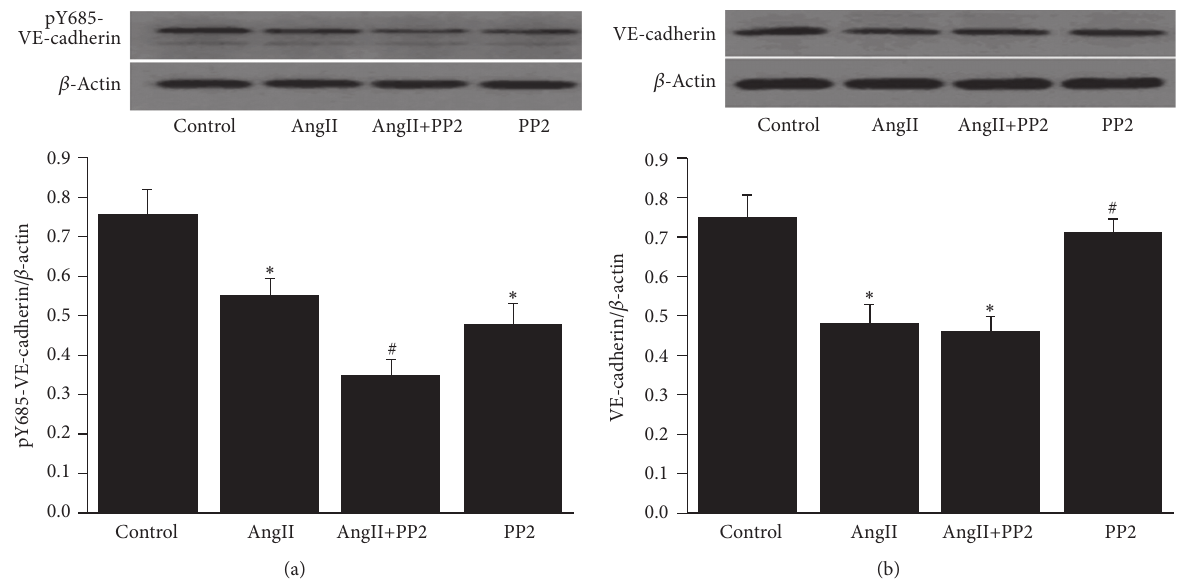
Figure5:DownregulationoftotalpY685-VE-cadherinproteininlunginducedbyAngII.(a)ThelevelofpY685-VE-cadherinwasremarkably decreased in the AngII group compared with the control group. AngII+PP2 induced further downregulation of pY685-VE-cadherin, while the pY685-VE-cadherin was obviously reduced in the control group after PP2 interference. (b) The VE-cadherin was remarkably reduced in the AngII group compared with the control group, but the level of VE-cadherin showed no difference after application of pp2. ∗ 𝑃 < 0.05 versus control group; # 𝑃 < 0.05 versus AngII group.